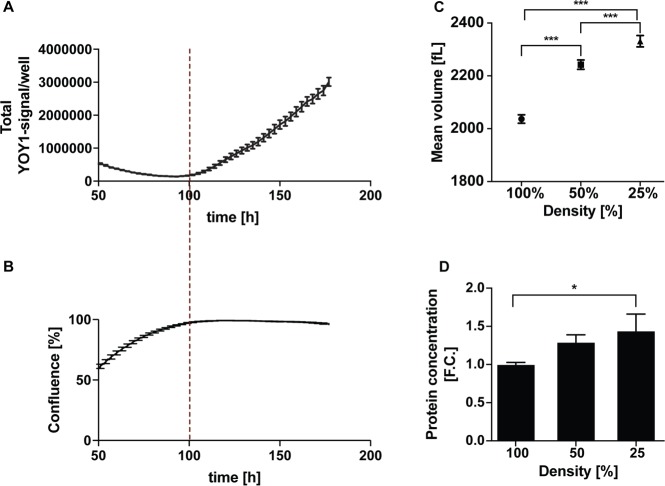
Culture density affects cell death rates and cell size.(A, B) Cell death was monitored using 50 nM of the fluorescent DNA-binding dye YOYO-1 that permeates only dead cells. Flipin-Trex cells were seeded in the presence of YOYO-1 which becomes fluorescent when bound to DNA. The rate of accumulation of green fluorescent signal/well is an indication of cell death over time. Cell death increases significantly once cells reach 100% confluence. (C) Cell volume of HEK293 cells was measured using Coulter Counter. Cells were counted and seeded the night before the measurement. Cells were seeded in 10 ml medium on a 10 cm dish at ~10×10^6, 5 × 10^6 and 2.5 × 10^6 cells/dish to achieve 100%, 50% and 25% confluence respectively. For the measurement cells were trypsinized and resuspended in Coulter measurement buffer. Each measurement represents the average volume from three independent plates ± S.D. (D) Protein concentrations of a total of 2.5 × 10^6 cells per density was done using BCA. Cells were cultured as described in C), trypsinized, counted, pelleted, washed in PBS and lysed in RIPA buffer; n = 3, mean ± S.D.